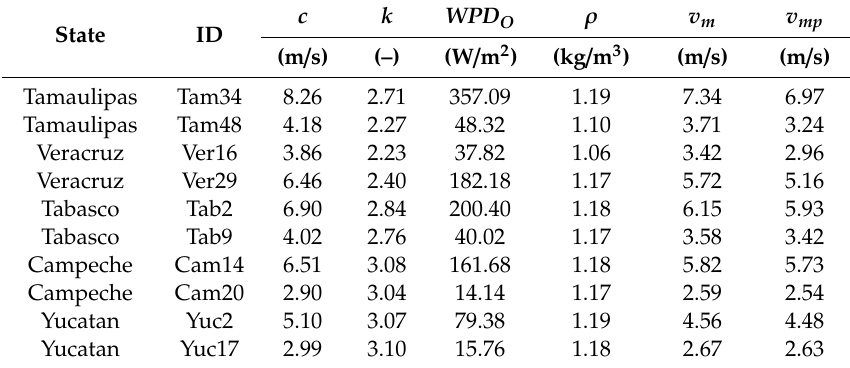
Table 1. MERRA-2